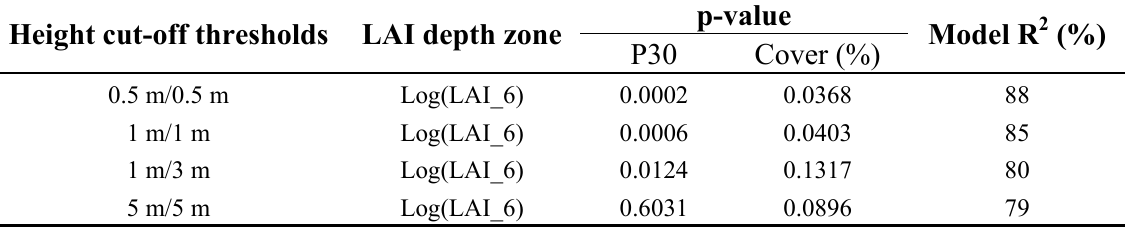
Table 5. Regression coefficient p-values and R 2 between cumulative LAI from the top of the canopy to 6 m above ground (LAI_6) and LiDAR metrics for a 9 year old pine forest based on all returns for P30 and cover based on first returns. Ground cut-off/cover height thresholds were selected to reflect the influence of various understorey tiers and the pine canopy on percentile height and cover